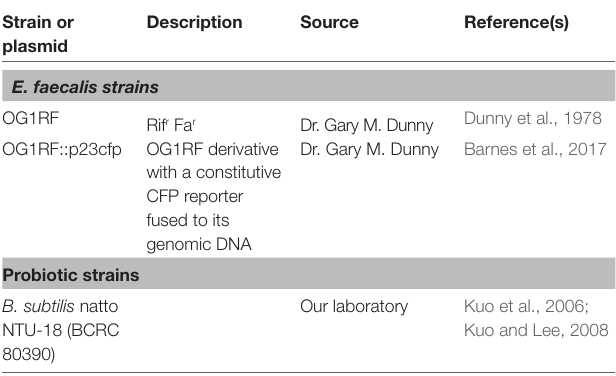
TABLE 1 | Bacterial strains used in this